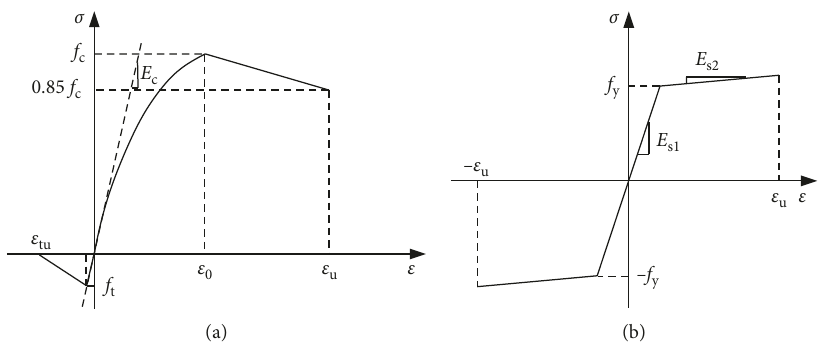
Figure 7: Stress-strain relation for materials. (a) Concrete. (b)